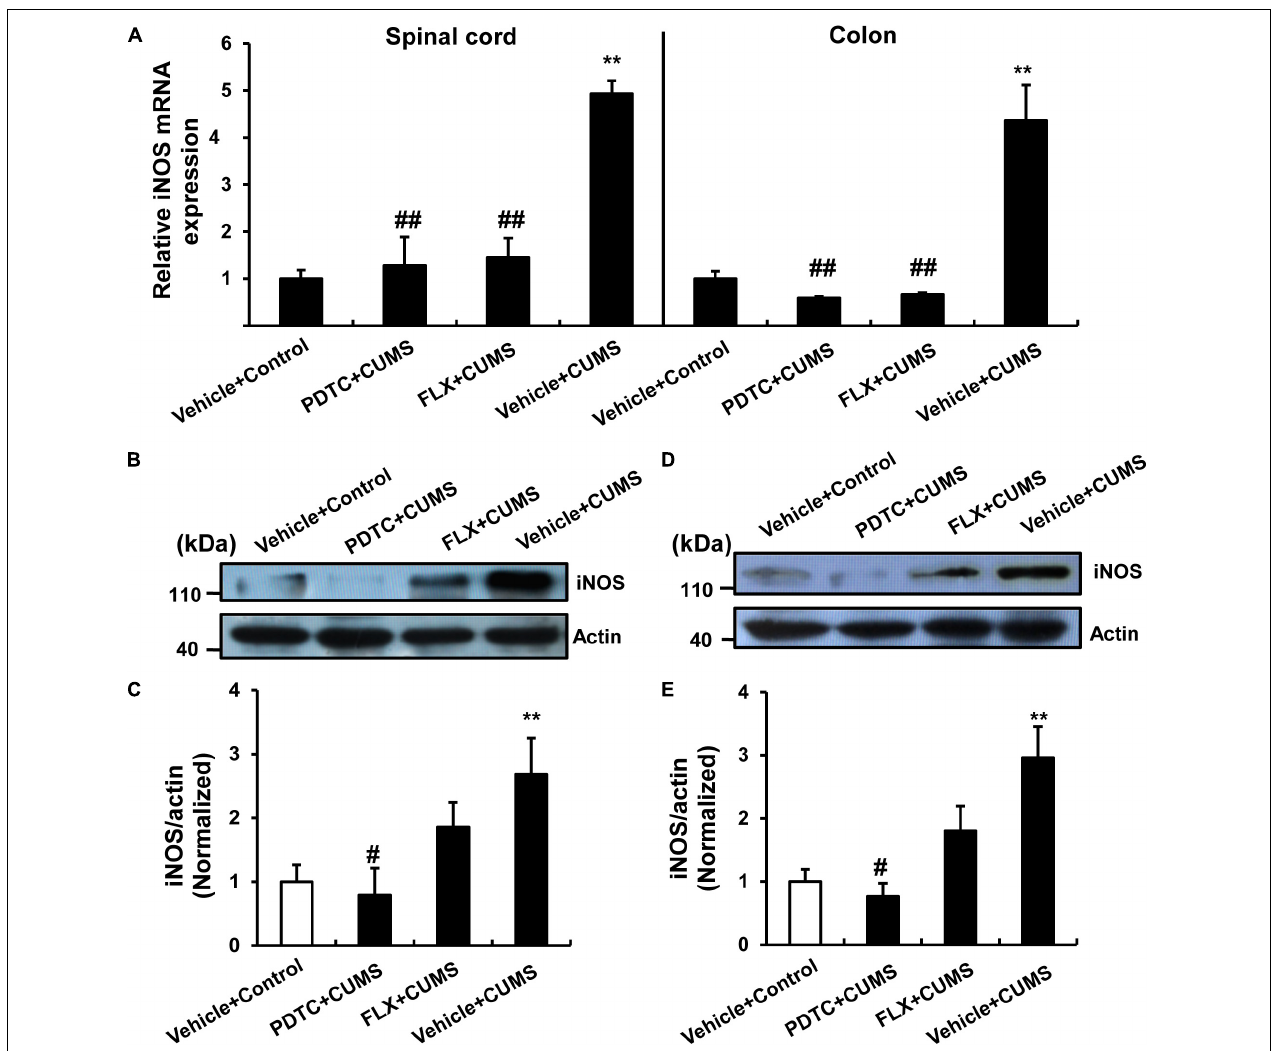
FIGURE 5 | PDTC prevented CUMS-induced expression of iNOS in both spinal cord and colon. (A) CUMS exposure resulted in a significant up-regulation of iNOS mRNA in spinal cord and colon. PDTC pretreatment reversed CUMS-induced increase in iNOS mRNA expression. Pretreatment with PDTC, but not fluoxetine, inhibited CUMS-induced increase in iNOS protein levels in the spinal cord (B,C) and colon (D,E) . All values are presented as mean ± SEM. n = 6 and ∗∗ p < 0.01 versus the control group. # p < 0.05 and ## p < 0.01 versus the CUMS group. FLX,